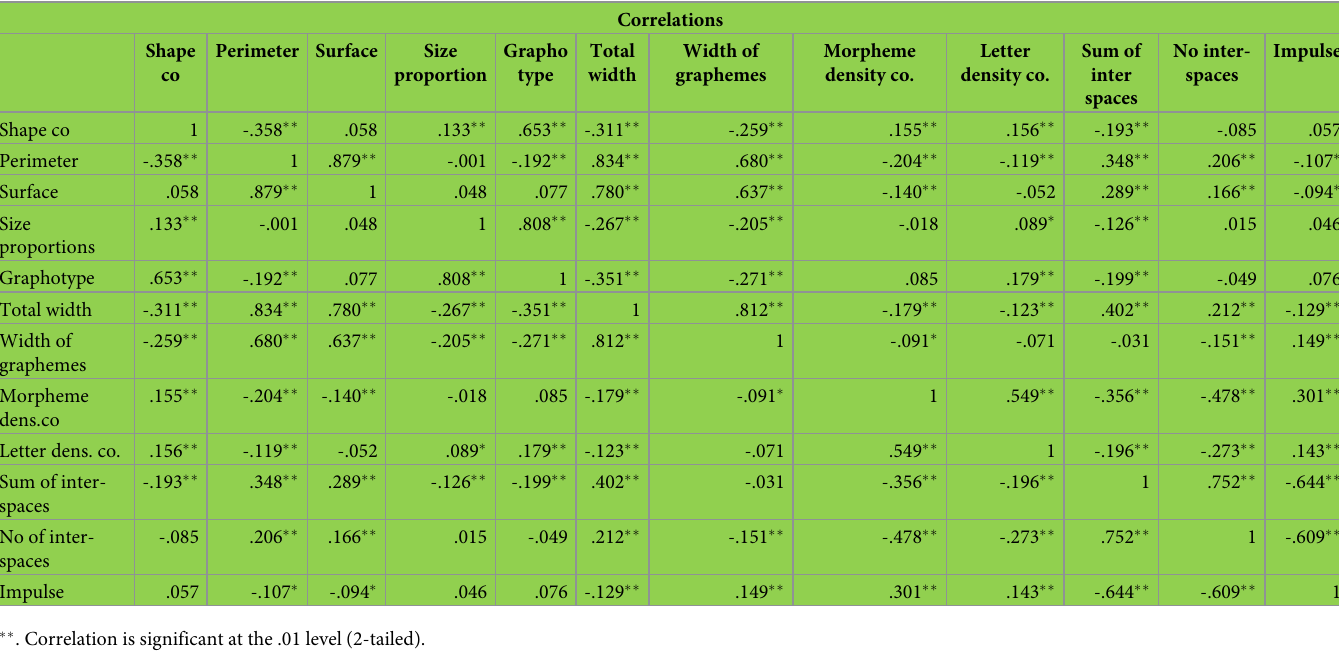
Table 3. Correlations ( τ -Kendall) between handwriting parameters ( n = 80).